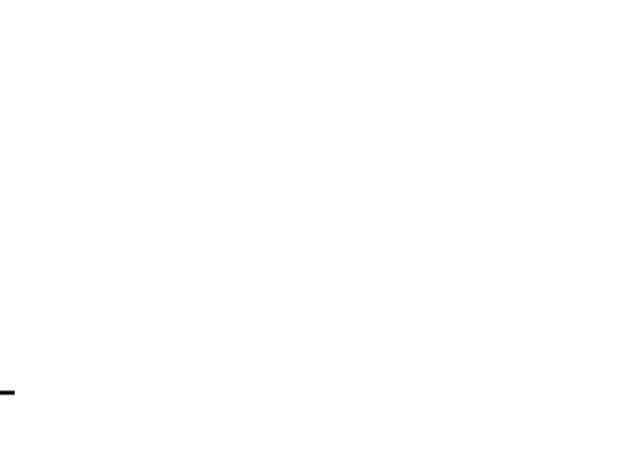
Figure 3. Relative expression levels of CYP6ER1 in AC-R (G 28 ) and UNSEL compared to AC-S. The bars with lowercase letters (a–c) are significantly different according to one-way ANOVA, followed by Tukey’s multiple comparison ( p < 0.05).